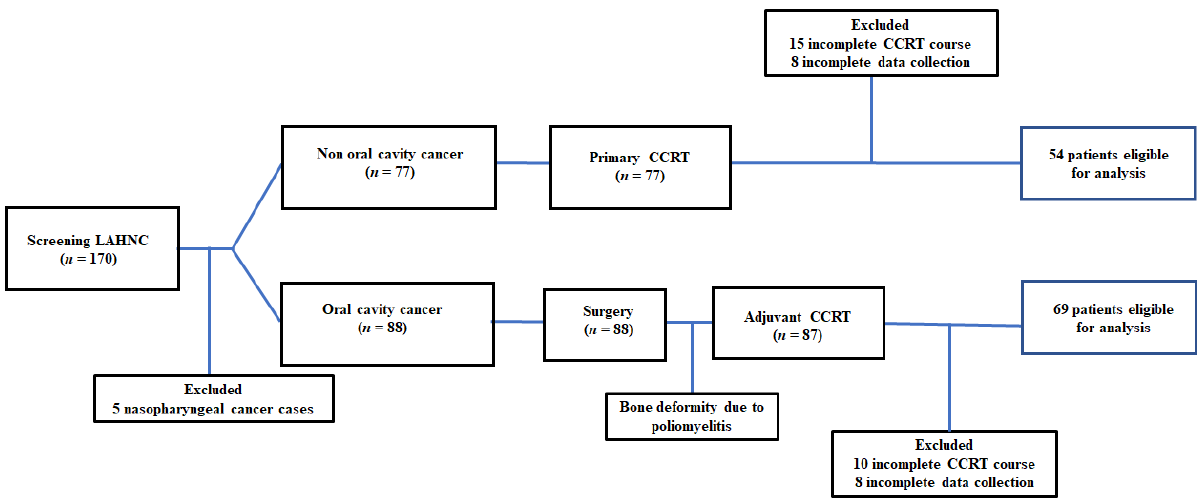
Figure 1. Flow diagram of recruitment. Patients who dropped out during the treatment or failed to receive at least four cycles of weekly cisplatin (40 mg/m 2 ) concurrently with planned radiotherapy (64–72 Gy) were considered as the incomplete CCRT subgroup. Patients who did not complete required DXA examinations or missed scheduled blood tests were considered as the incomplete data subgroup. LAHNC, locally advanced head and neck cancer; DXA, dual-energy X-ray absorptiometry; CCRT, concurrent